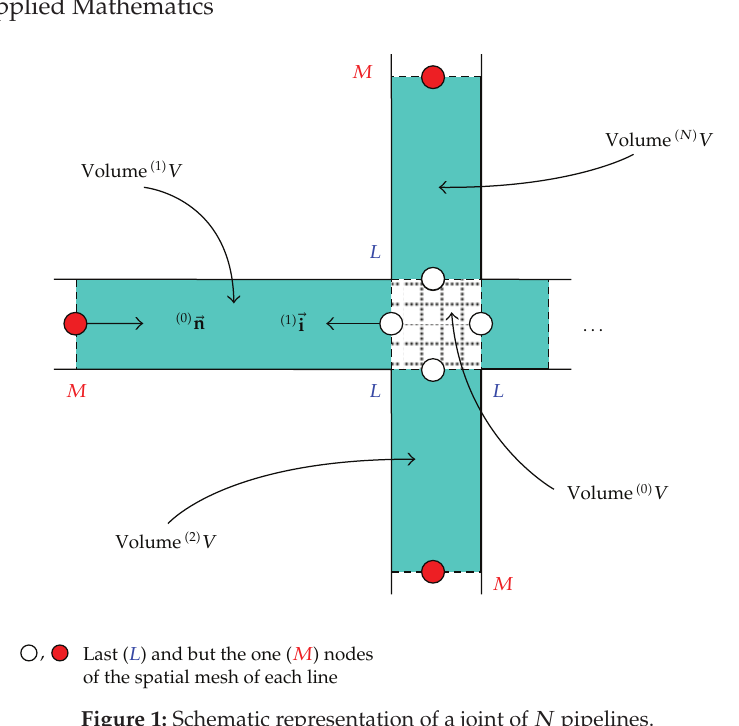
Figure 1: Schematic representation of a joint of N